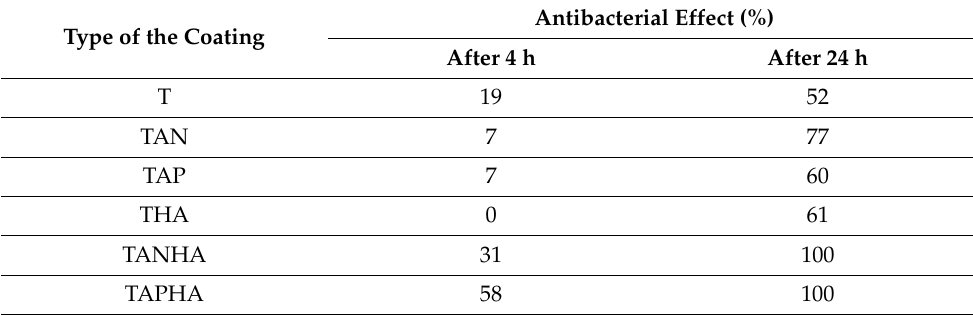
Antibacterial Effect (%)